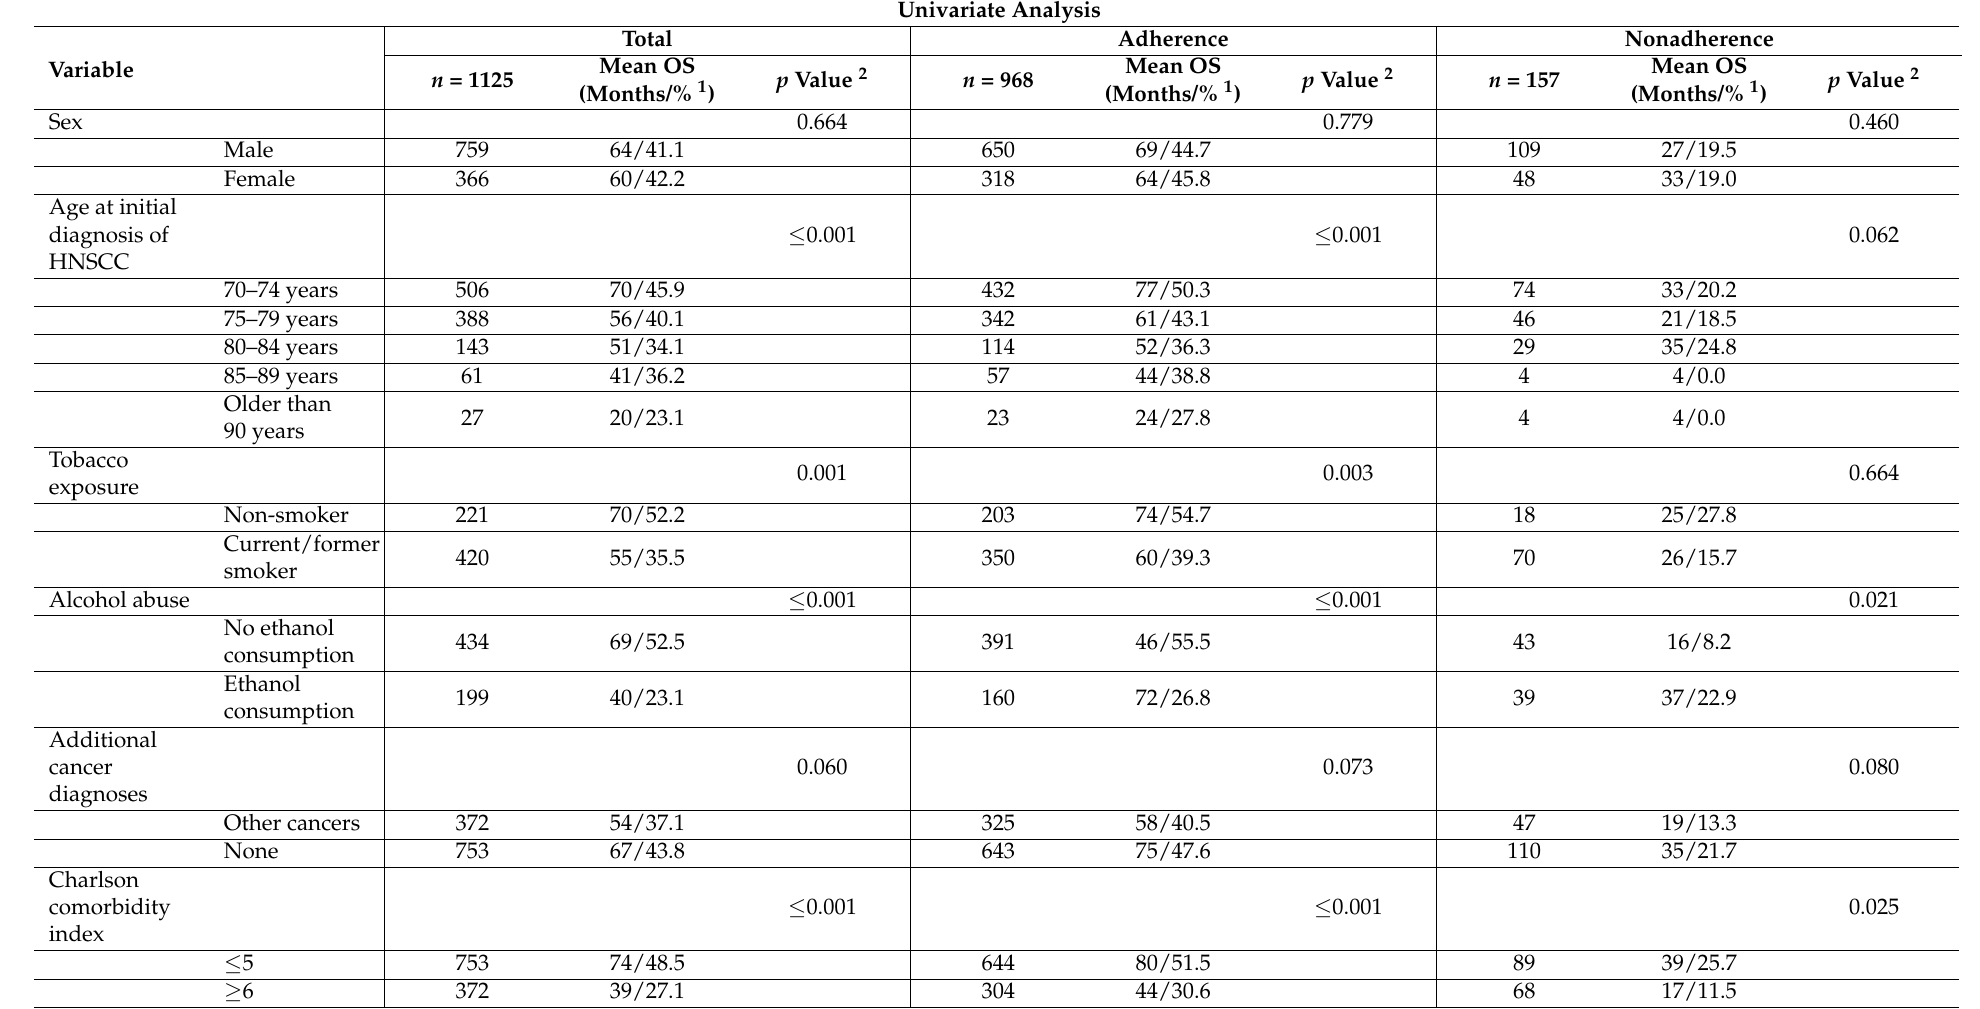
Table 4. Univariate and multivariate analysis of clinicopathologic variables associated with overall survival (Table S4). Univariate